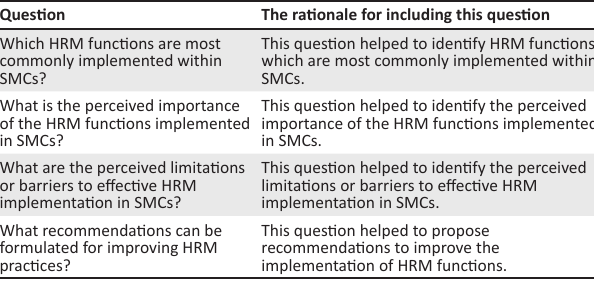
TABLE 2: Interview